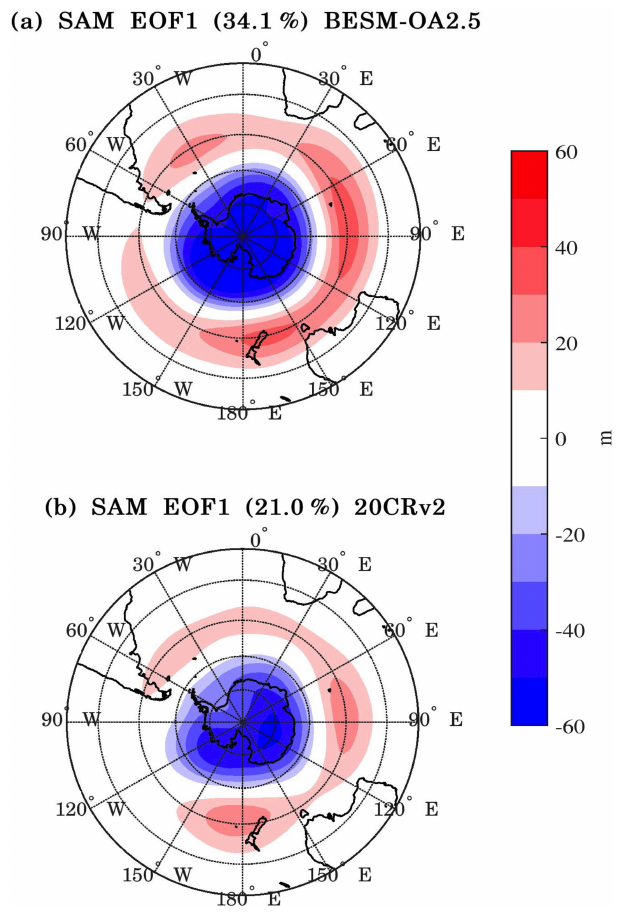
Figure 24. The leading EOF modes of the monthly mean 500hPa geopotential height field for the Southern Hemisphere (20–90 ◦ S) for (a) BESM-OA2.5 and (b) 20CRv2 reanalysis. The results are shown as the 500hPa geopotential height regressed onto the cor- responding normalized PC time series (meters per standard devia- tion) over the period 1950–2005. The percentages of the variance explained by each EOF are indicated in the titles of the figures. The contour interval is 10m.